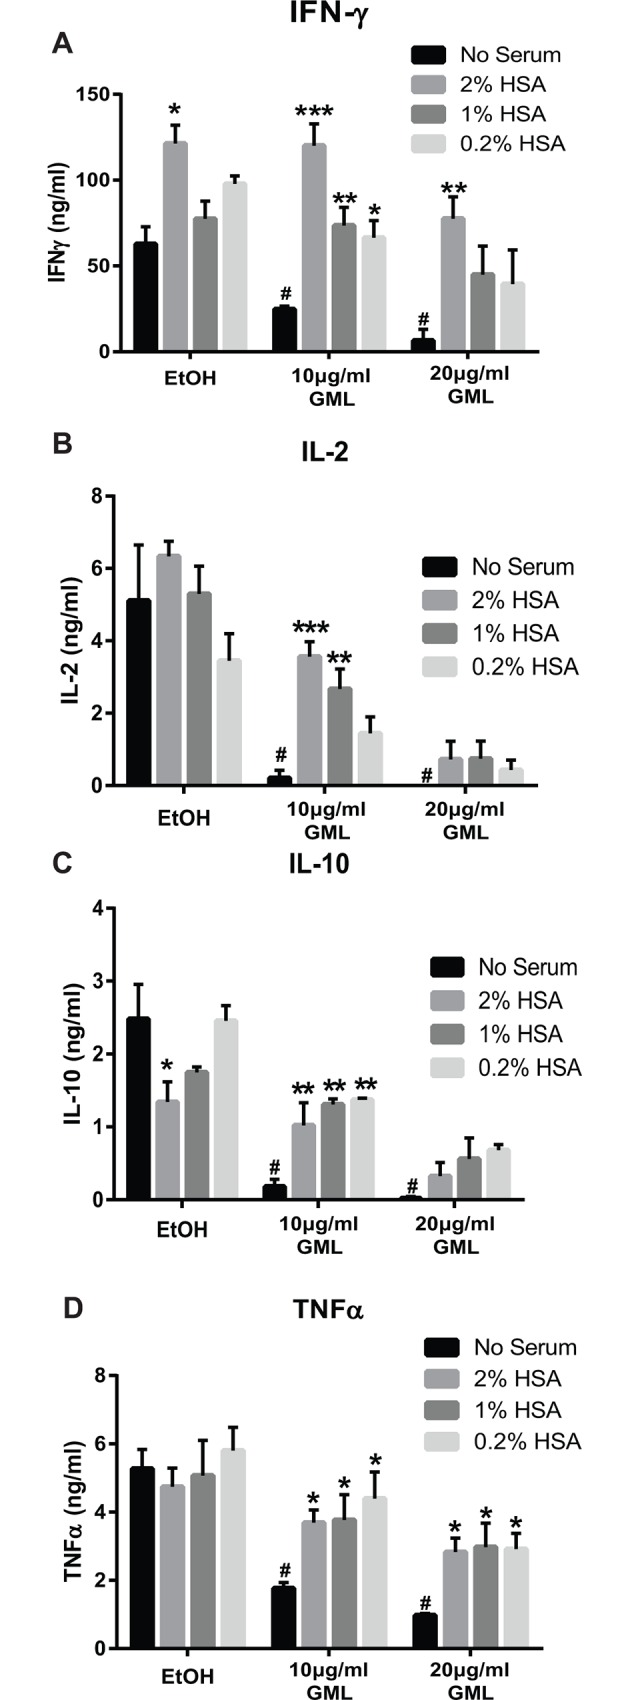
HSA differentially restores cytokine production in GML treated cells.APBTs were suspended in serum free RPMI or RPMI supplemented with 2%, 1% or 0.2% HSA and were treated with 0.2% ethanol vehicle control, 10 μg/ml, or 20 μg/ml of GML. Cells were plated on 2 μg/ml anti-CD3 coated plates for 24 hours. Extracellular cytokine production for (A) IFN-γ, (B) IL-2, (C) IL-10, or (D) TNFα was measured by ELISA in 3 independent experiments with different human donors. To statistically confirm that GML is suppressing cytokine production without serum, Student t’s test was done by comparing EtOH treated groups with GML treated groups under the same serum free environment, indicated by the black bars, with # denoting p<0.05. To statistically test for the effects of HSA on GML-induced cytokine production, Student t’s test was done by comparing groups with various concentrations of HSA supplemented media and serum free media with each test group (i.e. the x axis headings EtOH, 10 μg/ml GML, 20 μg/ml GML), with * denoting p<0.05, ** p<0.01, and *** p<0.005.